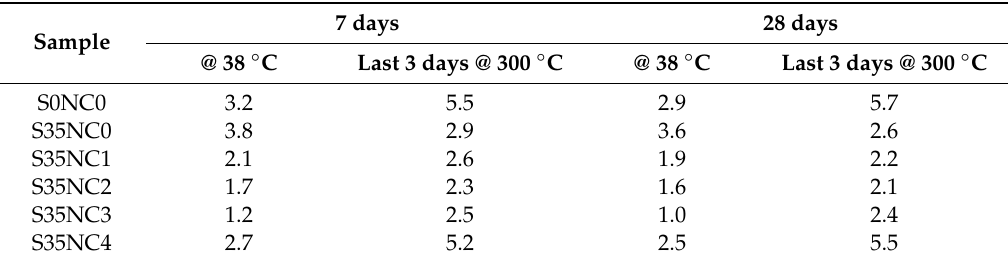
Table 6. The permeability changes in (mD × 10 − 3 ) for the cement samples cured for 7 and 28 days. For each case a sample represents every specimen cured at 38 ◦ C using the water bath for the whole curing time period while another sample removed and cured at 300 ◦ C during the last 3 days of curing period using the HPHT curing chamber to represent a condition similar to one cycle of steam